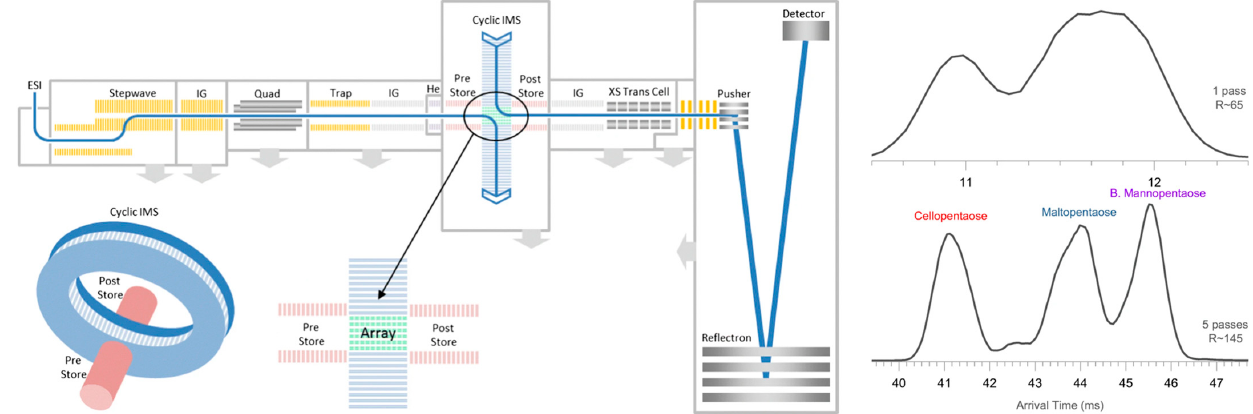
Figure 8. The geometry of the cIM-ToF mass spectrometer (left) and the increase in mobility resolving power by using 5-pass mobility separation in the cIM chamber for differentiating between different pentasaccharides [153]. Adjusted and reprinted with permission from Springer.